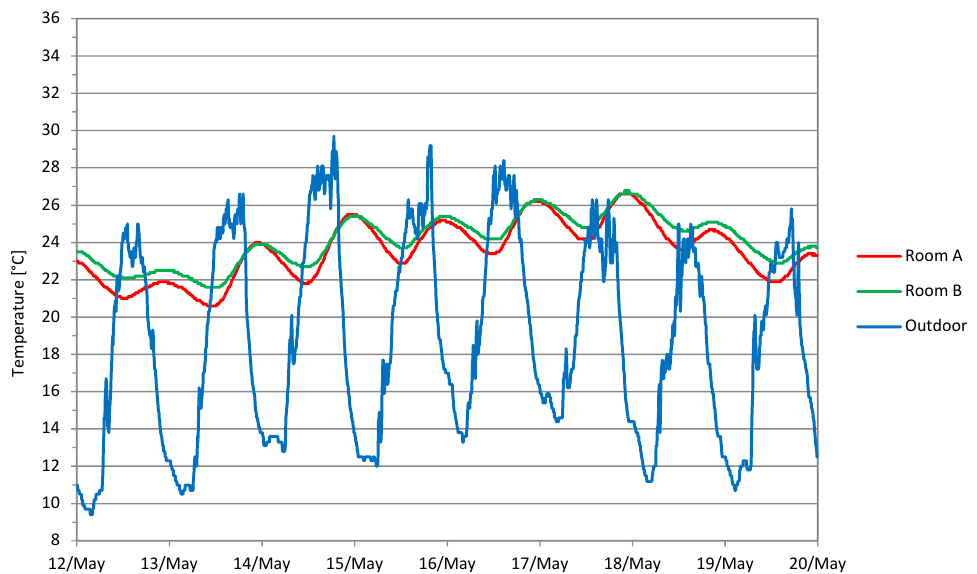
Figure 17. Indoor temperature in room A and room B as well as outdoor temperature during early summer, 12 through 19 May 2018.